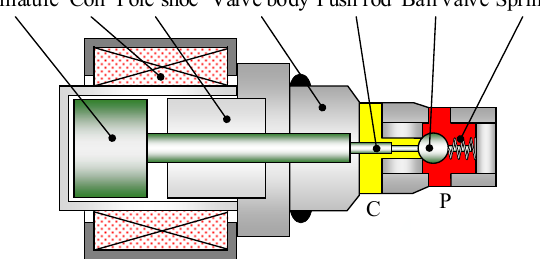
Figure 1. Structure diagram of the HSV driven by a solenoid.